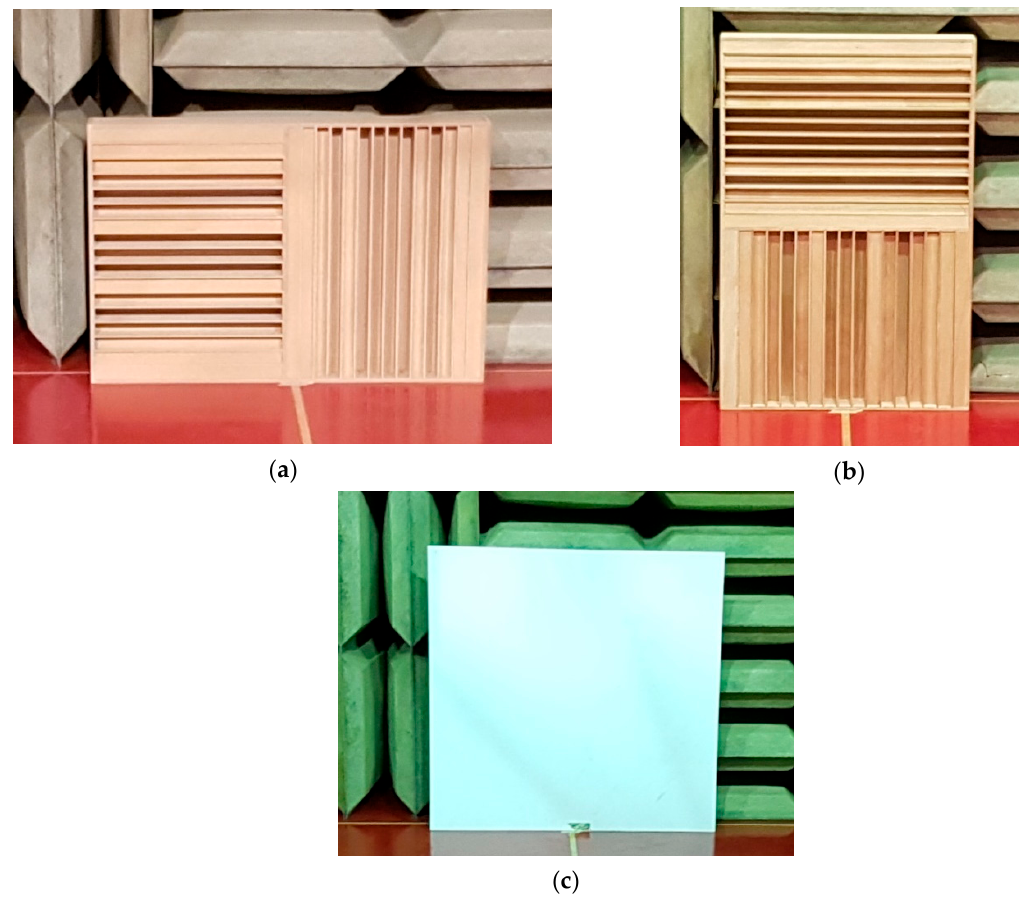
Figure 7. Diffusing panels made of MDF ( a ), plywood ( b ), and reflecting panel ( c ) tested inside the semi-anechoic chamber in SCM company in Rimini (Room A).